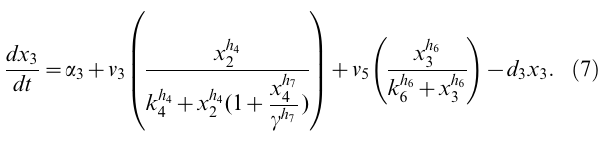
Figure S2 Expression of MET genes in wild type yeast cells.